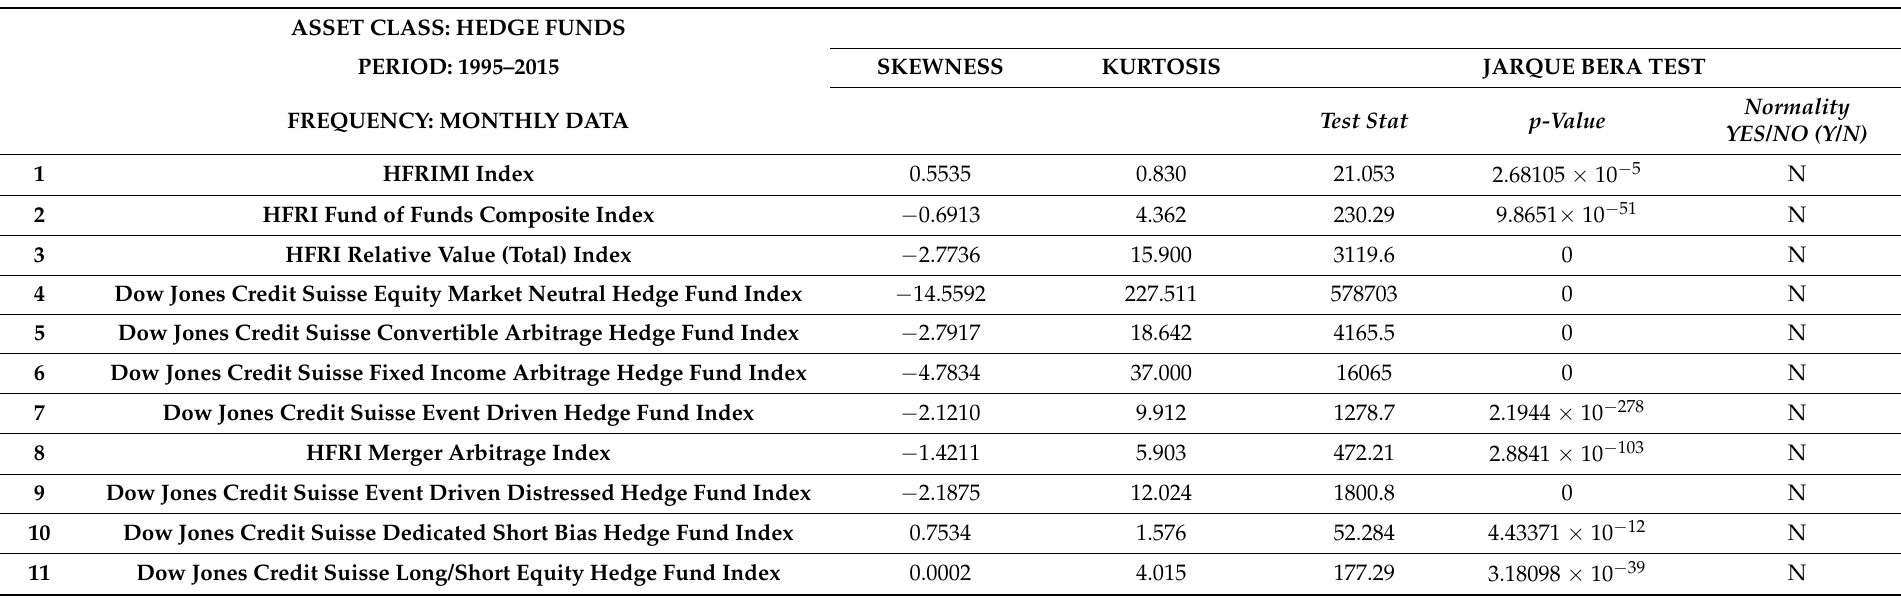
Table A1. Jarque Bera Test On Hedge Fund Data